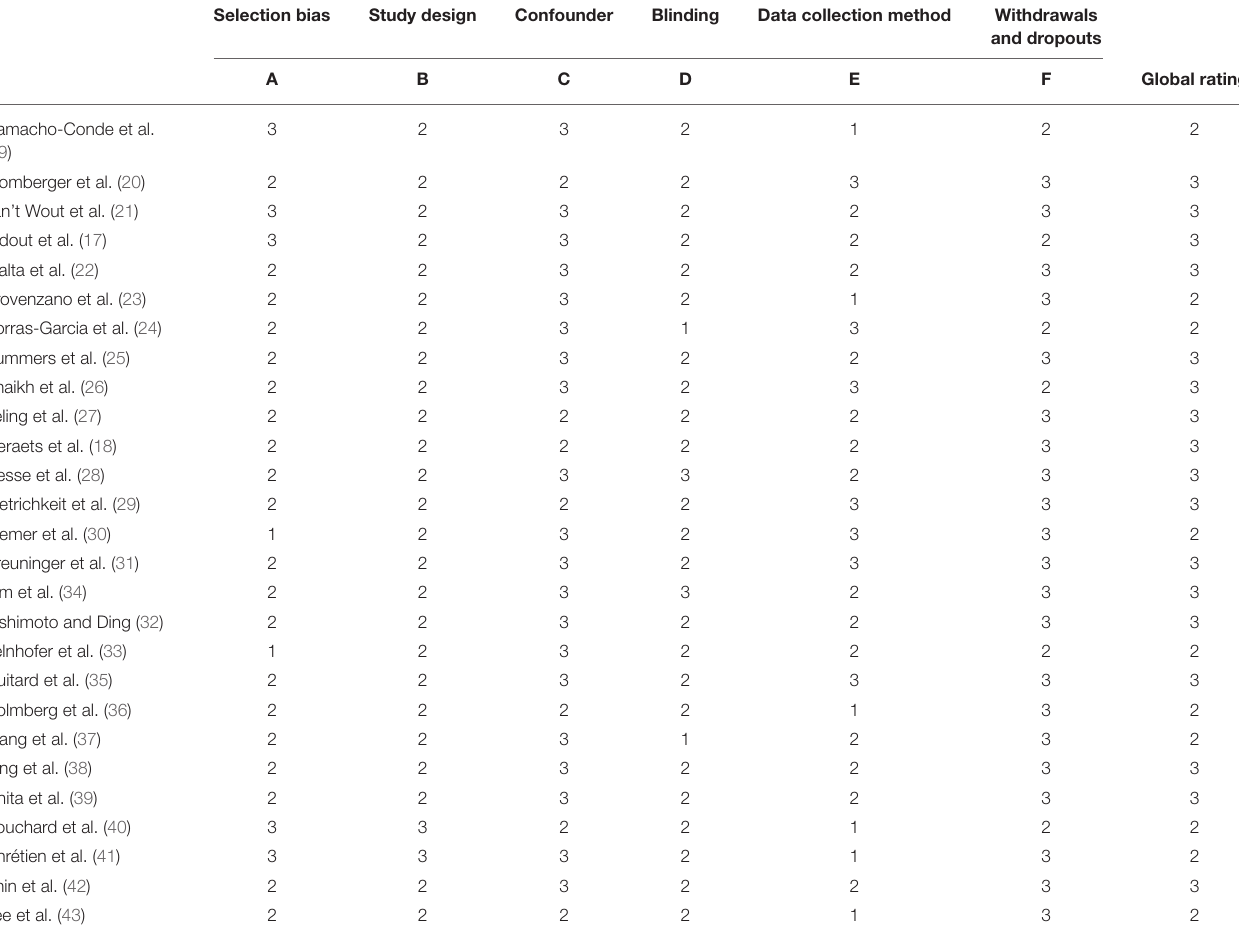
TABLE 2 | Immersive VR-assisted psychiatric assessment studies EPHPP quality